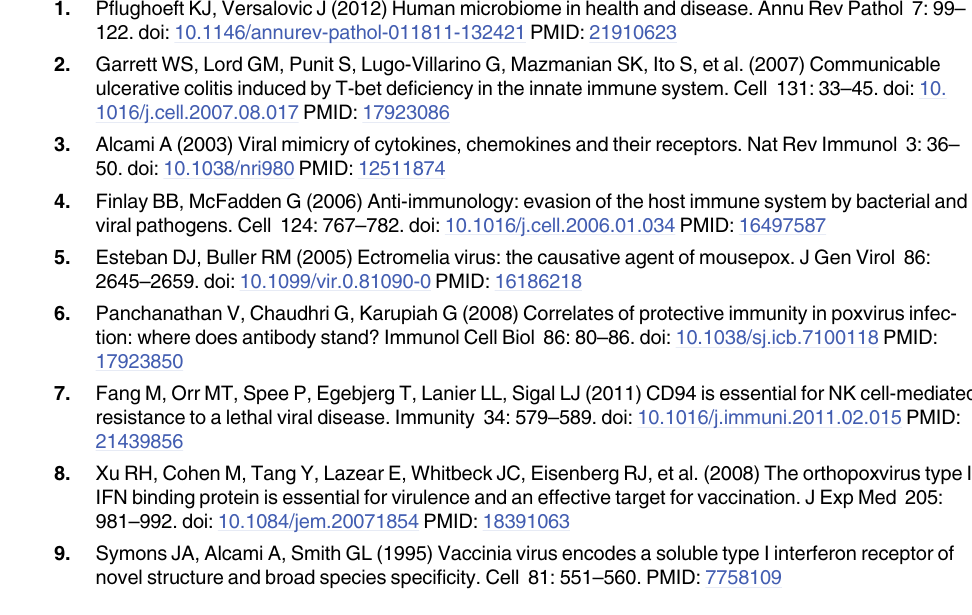
S1 Fig. Top 20 enriched IPA pathways in caecum after Ectromelia virus infection. Signifi- cant and differentially expressed genes from ECTV infected samples compared to control uninfected were used in a pathway enrichment analysis using IPA software (Ingenuity). Top 20 most enriched pathways and their corresponding p-values are shown. Lines connect over- lapping pathways sharing at least 5